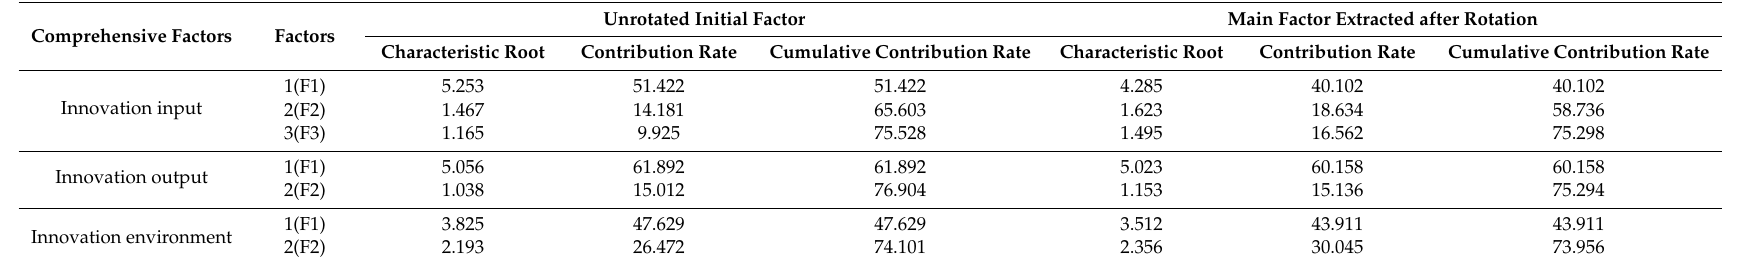
Table 2. Factor characteristic root and cumulative variance contribution rate %.